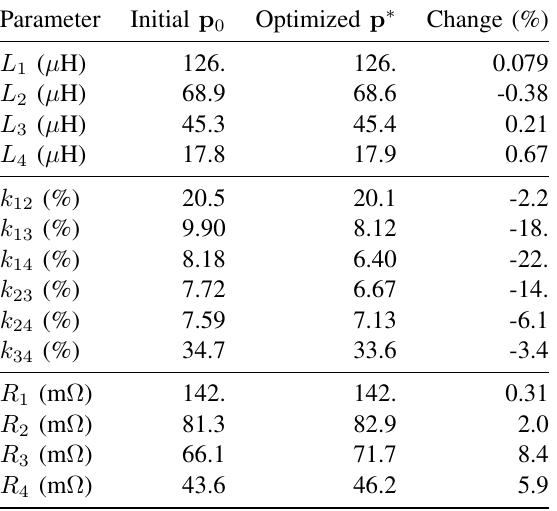
TABLE IV I NITIAL COMPONENT VALUES WHEN MEASURED INDIVIDUALLY FOR EACH COMPONENT BY A DIRECT PROCEDURE AND OPTIMIZED PARAMETER VALUES USING SYSTEM IDENTIFICATION PROCEDURE FOR WPT SYSTEM SHOWN IN F IG . 1 AFTER REASSEMBLY